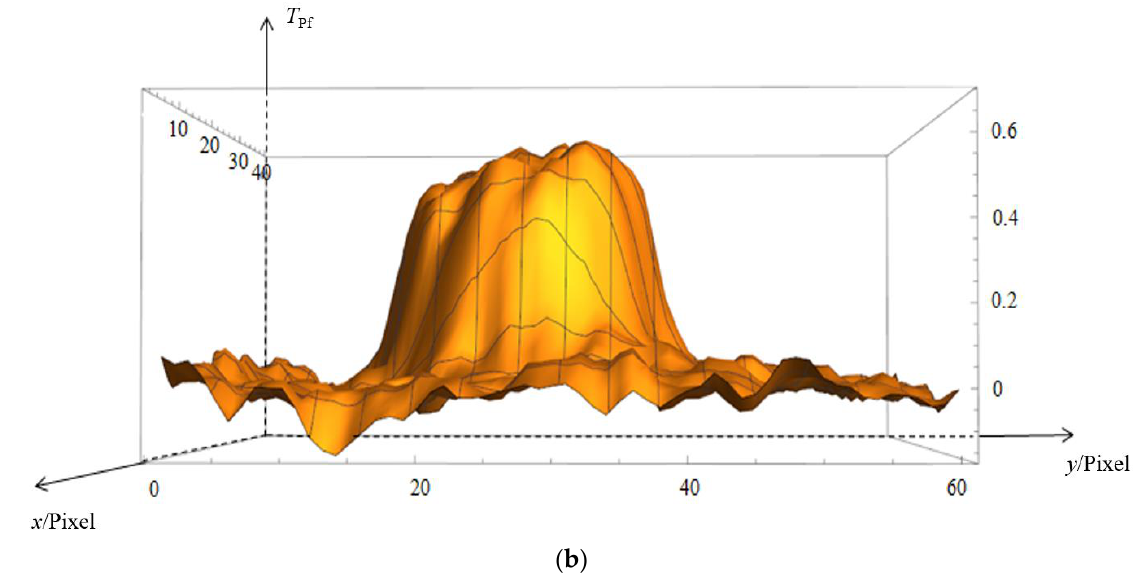
Figure 6. Three-dimensional thermal images of flaw 1 in the sample 1: ( a ) a raw thermal data extracted from PC1; ( b ) a thermal data extracted from PC1 after subtracting fitting background. Plane coordinates are represented by x -axis and y -axis. Vertical axis is used to record the value of temperature. Red line represents the coordinate range in y -axis, where the temperature has an abnormal rise.